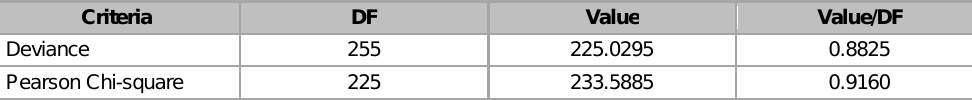
Goodness of fit statistic for the logistic regression